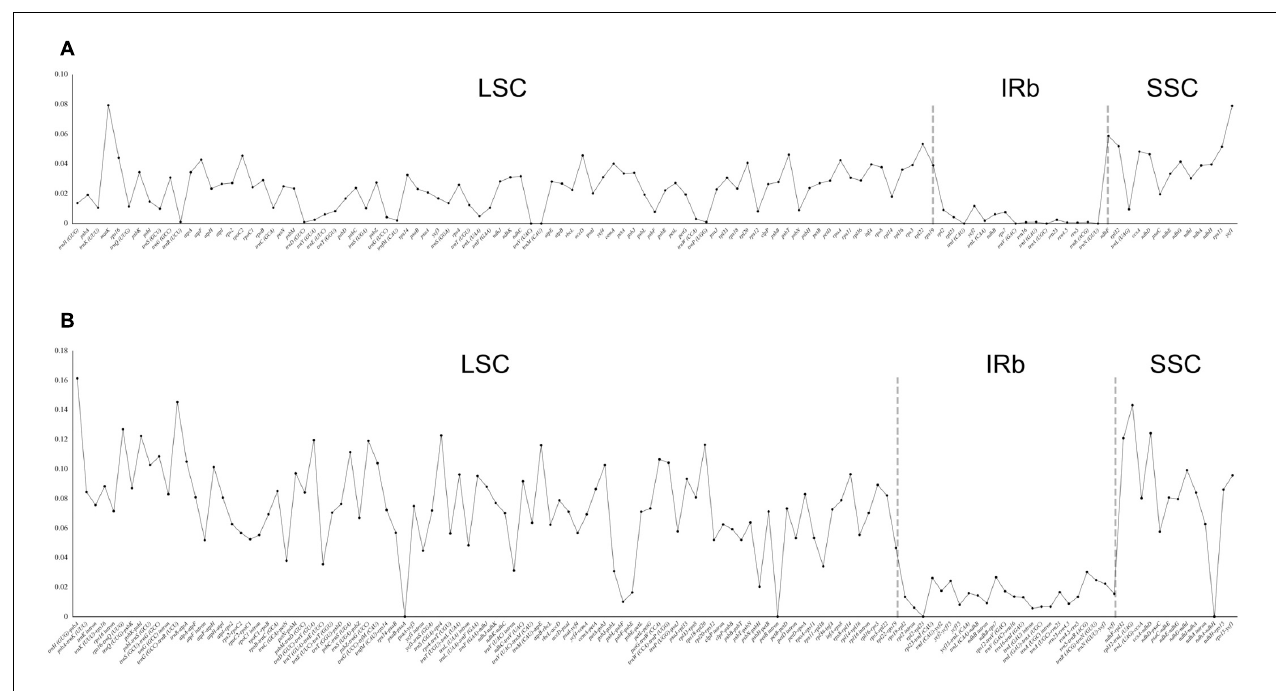
FIGURE 2 | Distribution of nucleotide diversity ( π ) in coding (A) and non-coding (B) regions of 26 Crassulaceae chloroplast